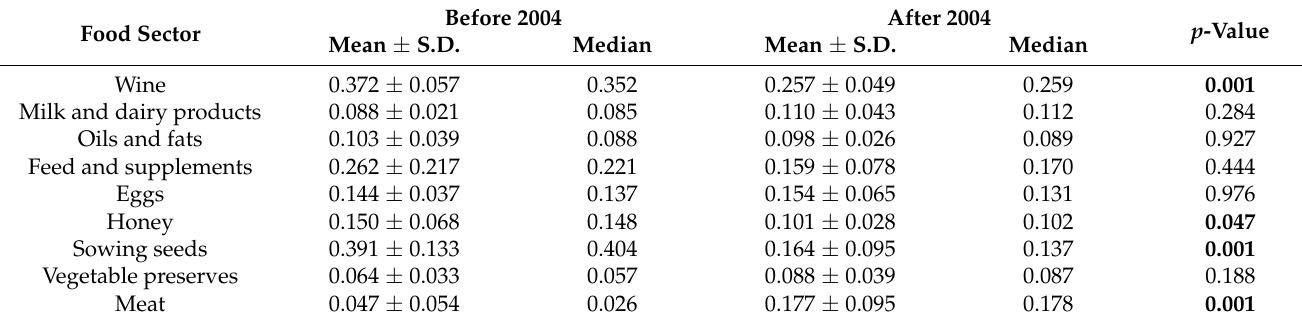
Table 4. Descriptive statistics of dispute rates and p -values related to comparisons between two periods.